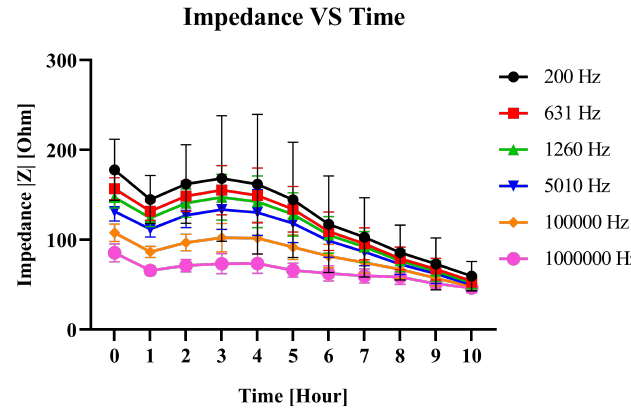
Figure 3: Plot of mean impedance values with 95 % confidence interval against time (0 to 10 hours) for selected